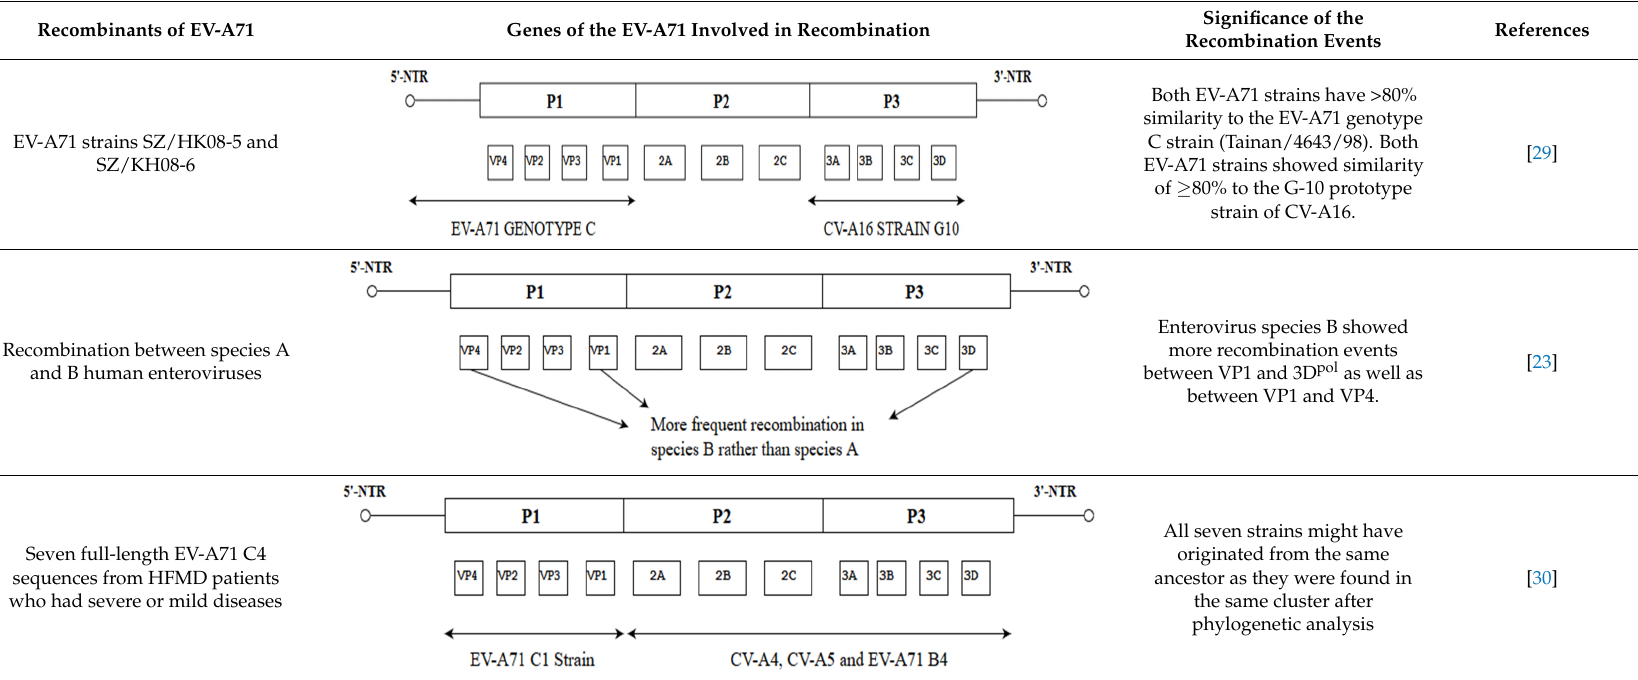
Table 1. Recombination events in the genome of EV-A71.